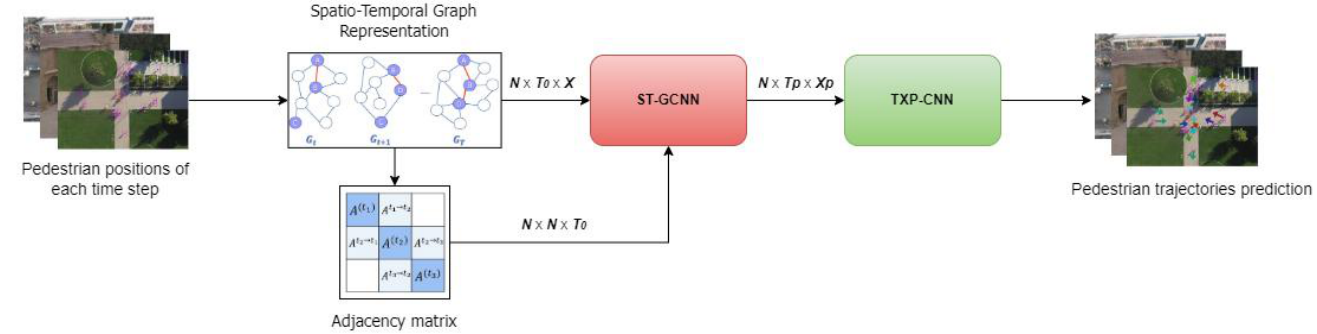
Figure 3. Overall architecture of the proposed method. Through optimization of the layer size, increased accuracy in trajectory prediction is also possible.